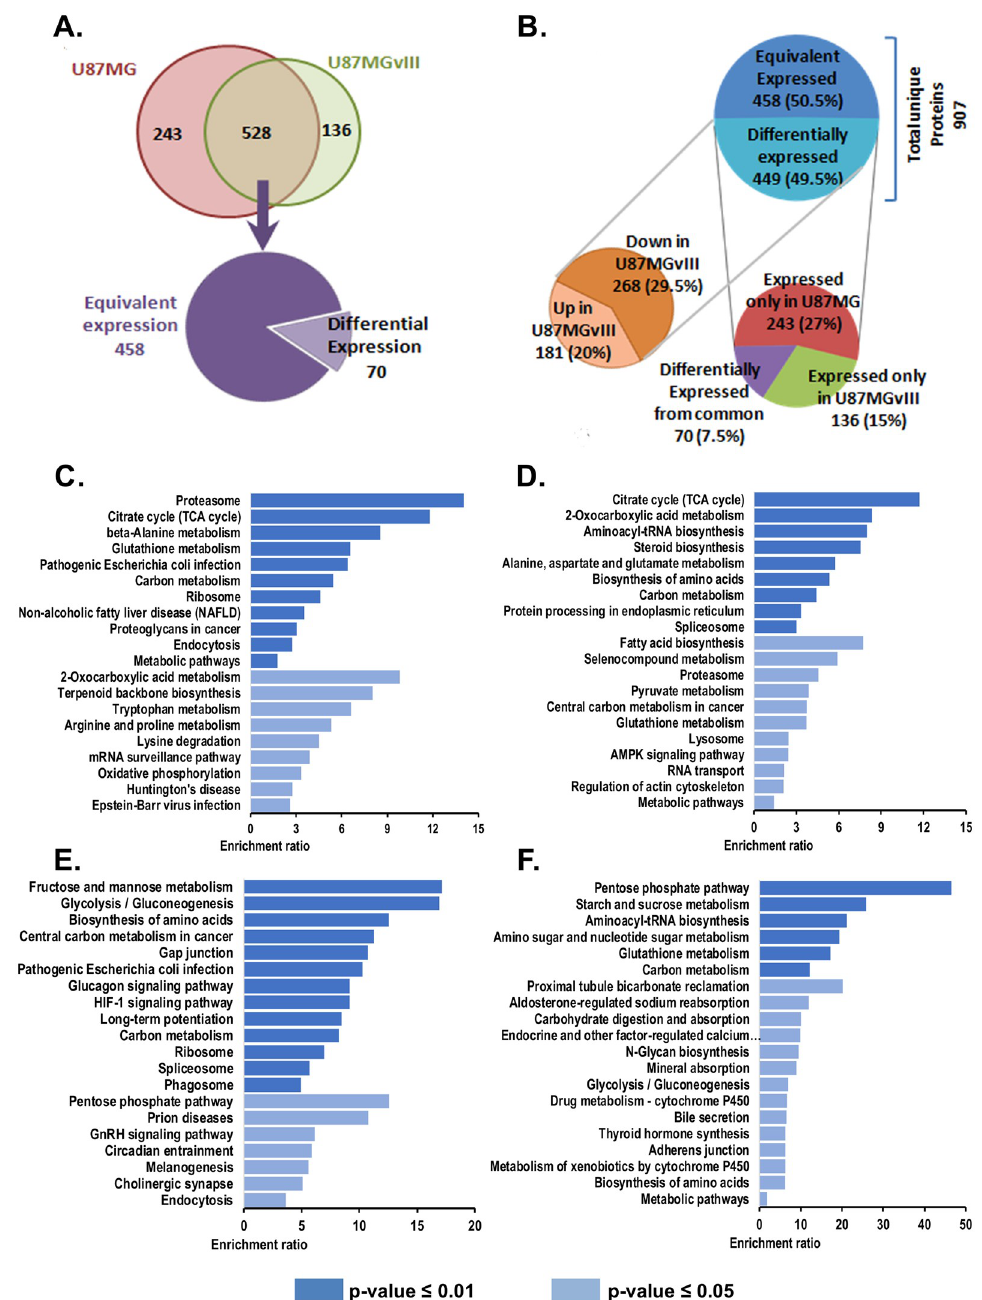
Fig 4. Comparative proteome analysis between the GBM cell lines U87MG (EGFRwt) and U87MGvIII (EGFRvIII). Protein identification and quantification were done by nano-HPLC Q-TOF MS/MS and peptide searches using the SwissProt databank for human proteins. Quantitation of the protein expressions was label-free by calculating the emPAI values for each protein. (A) Venn diagram for the statistics of proteins identified in U87MG and U87MGvIII. In three independent biological replicates of the proteome analysis for each cell line 907 proteins were identified, 528 common, 243 only for U87MG and 136 only for U87MGvIII cells. Of the shared proteins, 458 were equivalently and 70 differentially expressed. (B) Distribution of equivalently and differentially expressed proteins. Of the 449 differentially expressed proteins 243 were only present in U87MG and 136 in only U87MGvIII and 70 were present in both but in differential expression (down right). In total 268 were up-regulated and 181 down-regulated in U87MGvIII compared to U87MG. (C-D) Pathway over-representation analysis. Panels C and D plot the enriched pathways for proteins exclusively overexpressed in U87MGvIII (EGFRvIII) and U87MG (EGFRwt), respectively. One thirty four out of 136 and 235 out